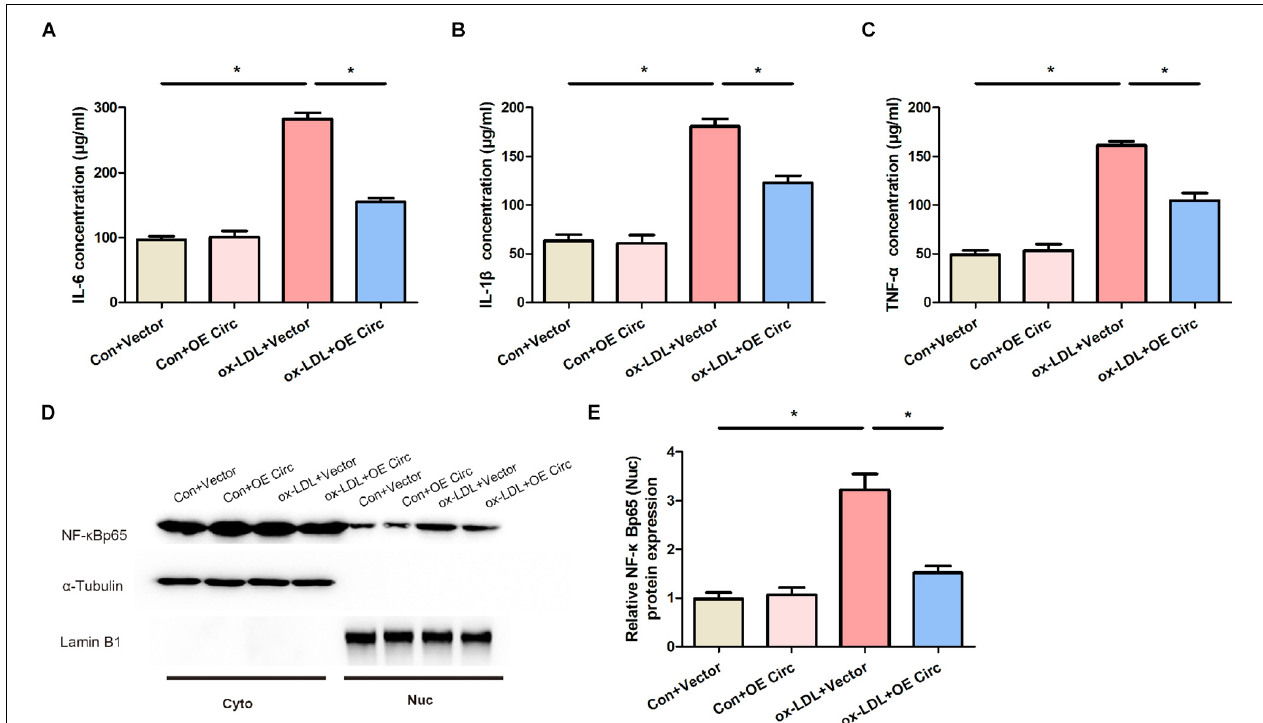
FIGURE 3 | Overexpression of circ_0065149 decreased the expressions of IL-6 (A) , IL-1 β (B) , TNF- α (C) , and NF- κ Bp65 (D,E) in ox-LDL-induced HUVECs. The expression of NF- κ Bp65 was assessed in the nuclear and cytoplasmic fractions, respectively. Data are presented as means ± SD . * P < 0.05, Vector vs. the Control group; ox-LDL + OE Circ vs. the ox-LDL Vector group.